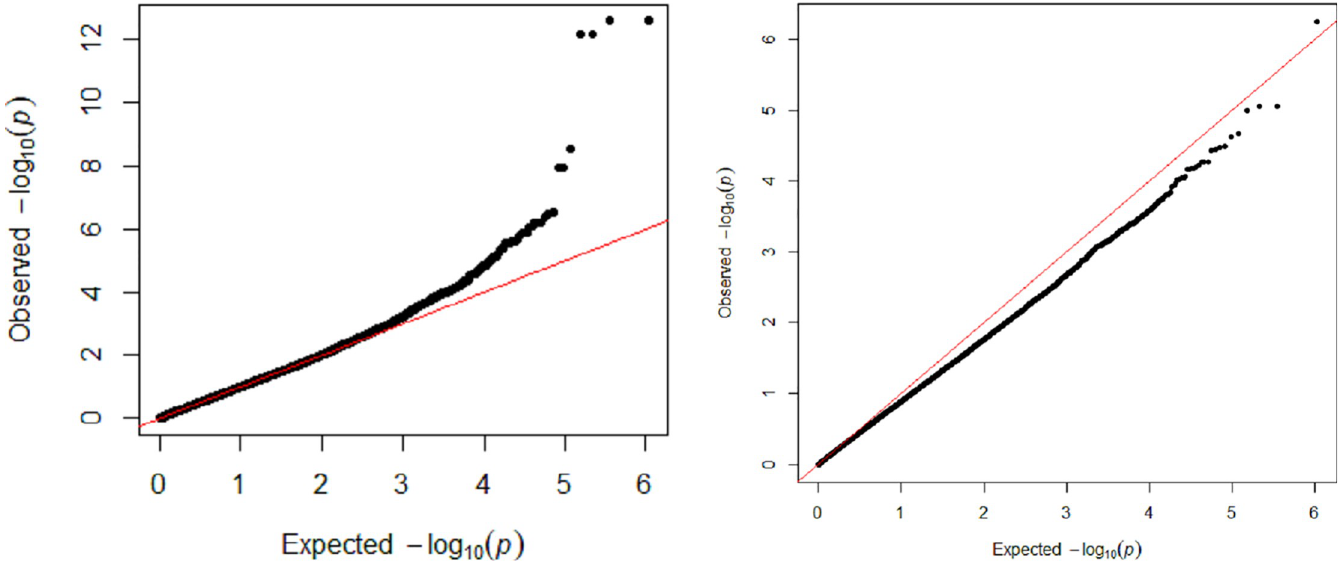
Fig 3. Quantile-Quantile plots for the all-breed analysis with untransformed M . ovipneumoniae mean DNA copy number, showing deviation due to significant SNPs (A) and less deviation when top 7 SNPs are included as covariates in the analysis (B).